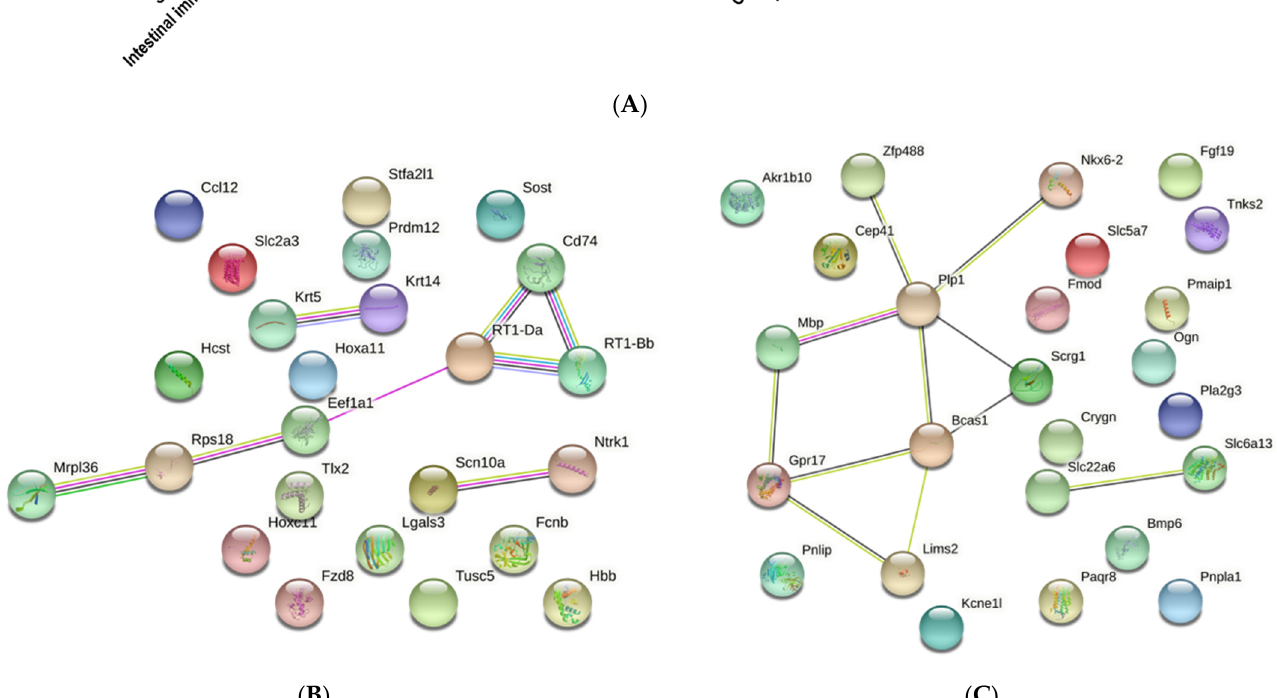
Figure 11. KEGG and protein–protein interaction network analysis of differentially expressed genes in the spinal cord of MMC and vehicle fetuses isolated at E20. ( A ) Top 10 KEGG pathways upregulated and downregulated as determined by percent total changed genes in each pathway. All pathways were greater than 1.5-fold change and p < 0.05. ( B , C ) Protein– protein interaction network analysis based on top 25 ( B ) upregulated and ( C ) downregulated differentially expressed